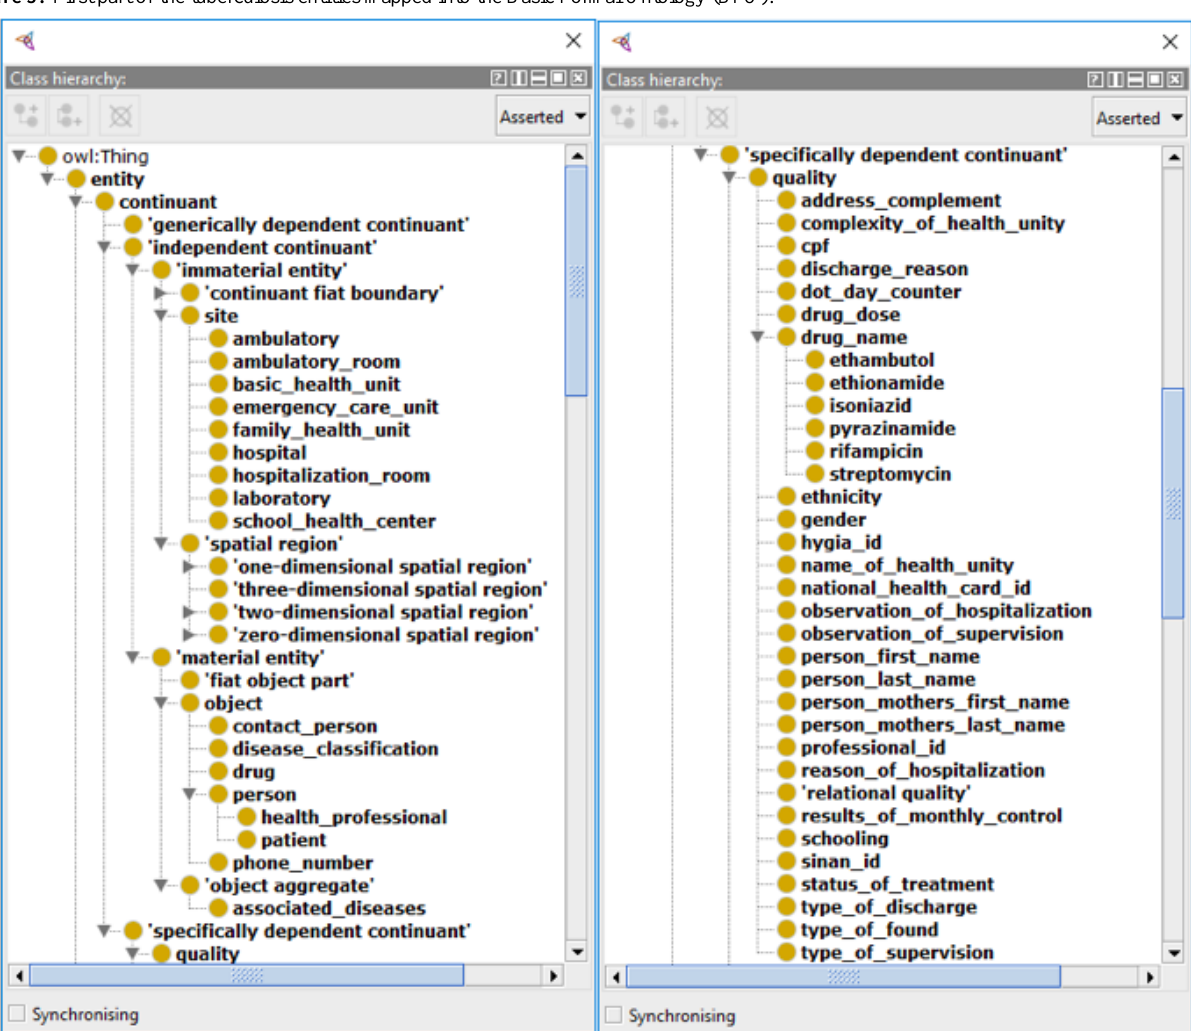
Figure 3. First part of the tuberculosis entities mapped into the Basic Formal Ontology